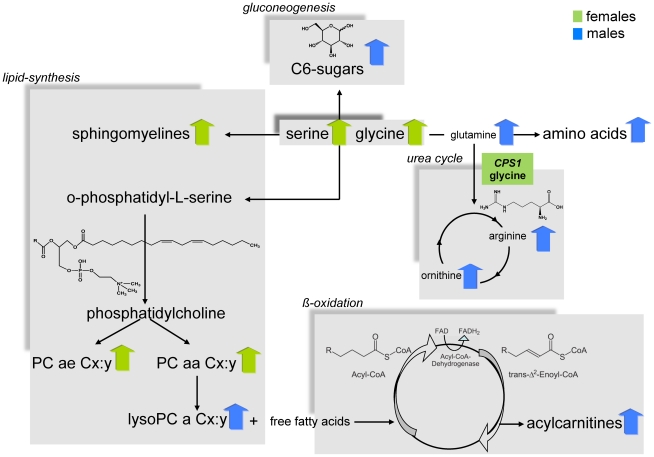
Systematic view of metabotype variations in the metabolism of males and females.It also shows the suggestive locus that is located in a gene encoding an enzyme that is central in human metabolism. CPS1 is related to the amino acid metabolism. For this locus the metabolite with the strongest association is provided (green box). A blue arrow indicates metabolite concentrations which are higher in men than in women; green arrows vice versa.